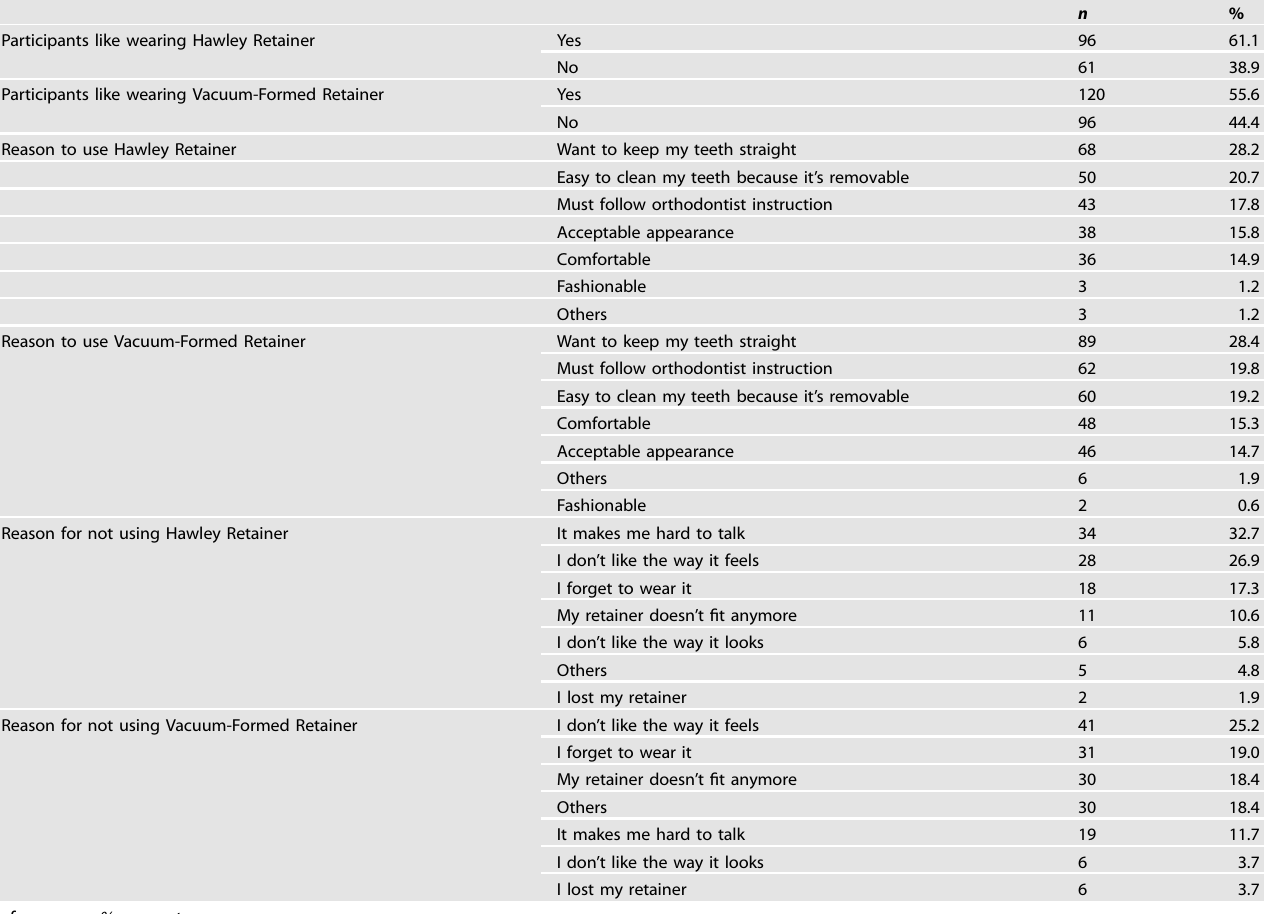
Table 3. Reasons participants like and dislike using